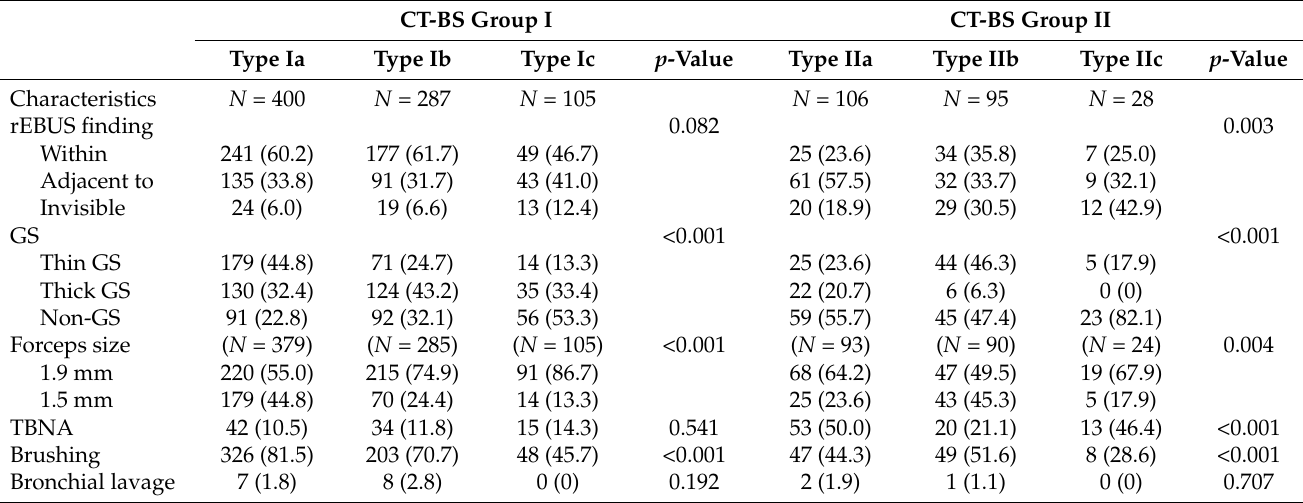
Table 3. Procedural details for all bronchus types.